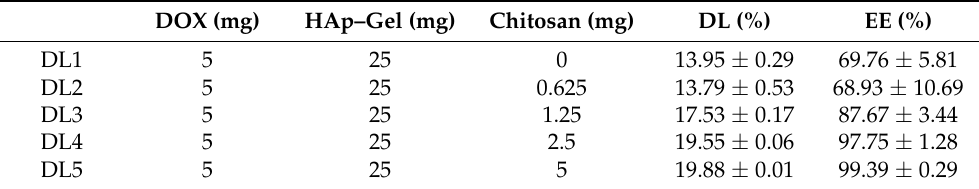
Table 3. DL and EE with various weight ratios of HAp–gelatin porous composite microspheres to chitosan for DL1, DL2, DL3, DL4 and